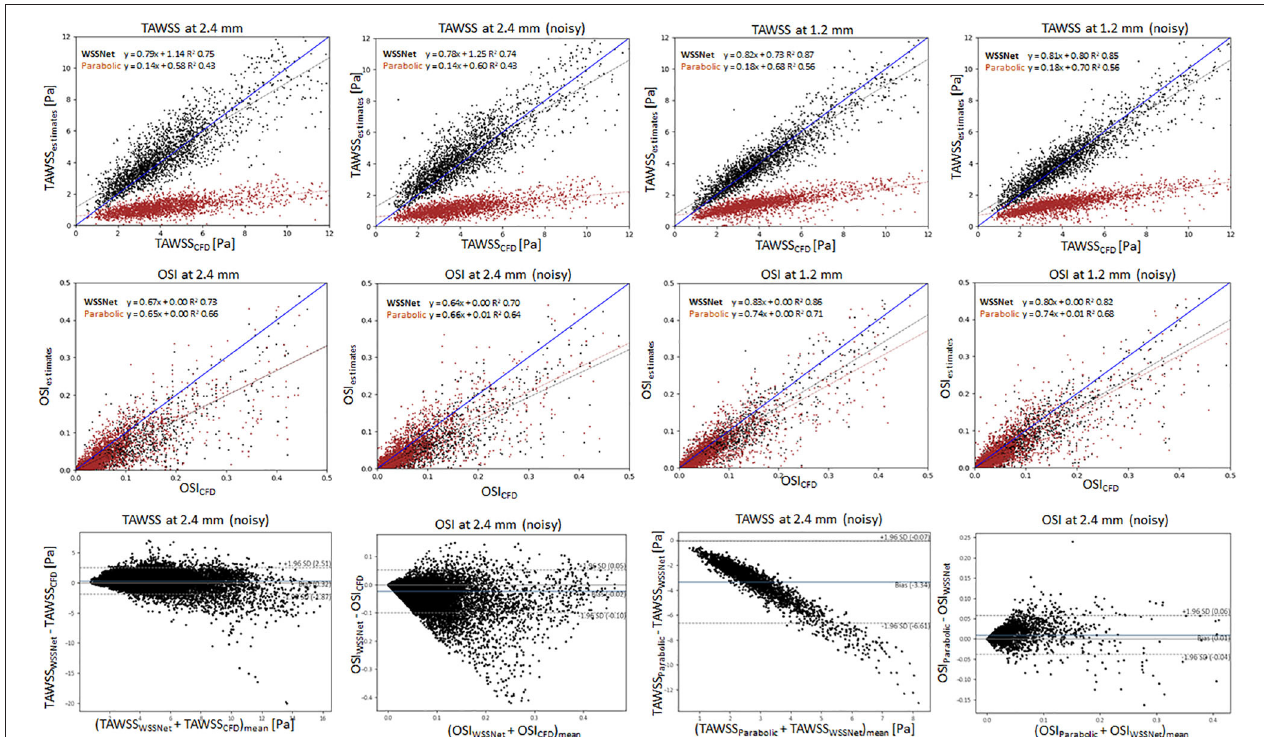
FIGURE 10 | Top: Linear regression plots of TAWSS for synthetic MRI using WSSNet (black) and parabolic fitting method (brown) at different resolutions (dx = 2.4 and 1.2mm) with and without noise, compared with ground truth CFD. Middle: linear regression plots for OSI at different resolutions (dx = 2.4 and 1.2mm) with and without noise, compared with ground truth CFD. Bottom left: Bland-Altman plots of TAWSS and OSI between WSSNet and ground truth CFD at 2.4mm noisy synthetic MRI. Bottom right: Bland-Altman plots of TAWSS and OSI between parabolic fitting method and WSSNet at noisy 2.4mm synthetic MRI. The plots show 20% of the data points, randomly